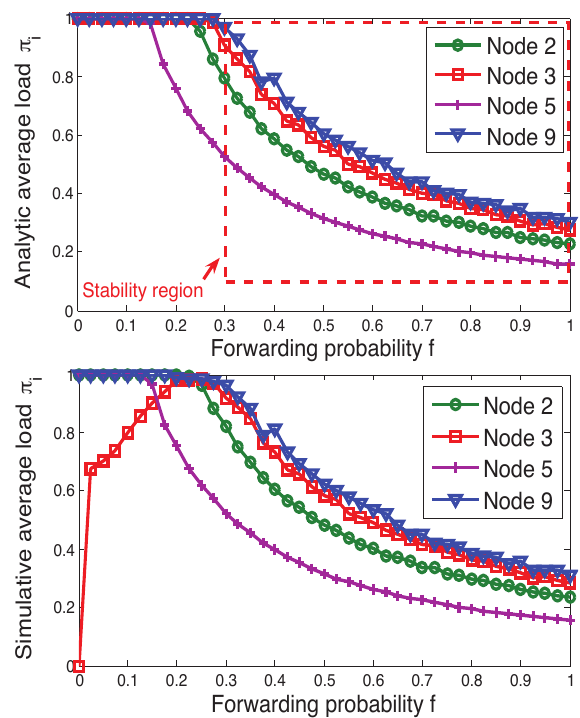
Figure 5. Average forwarding queues load from model versus simulation as function of forwarding probability.